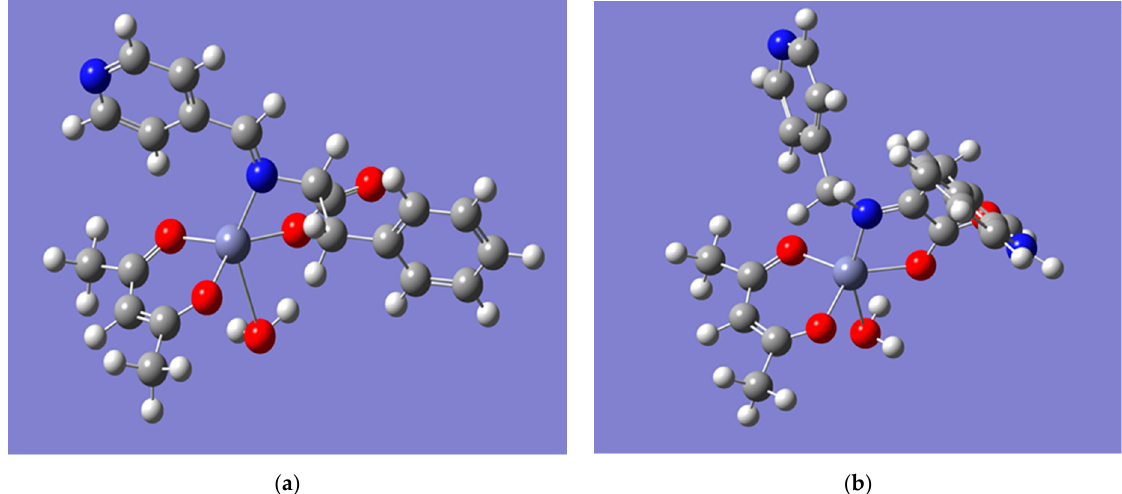
Figure 6. The geometry of the complexes calculated by Gaussian 03 with the DFM method and B3LYP/6-31G ∗ Orbital Basis Set: ( a ) Zn [(acac) (LPhe)H 2 O], and ( b ) Zn[(acac)(LTrp)H 2 O].